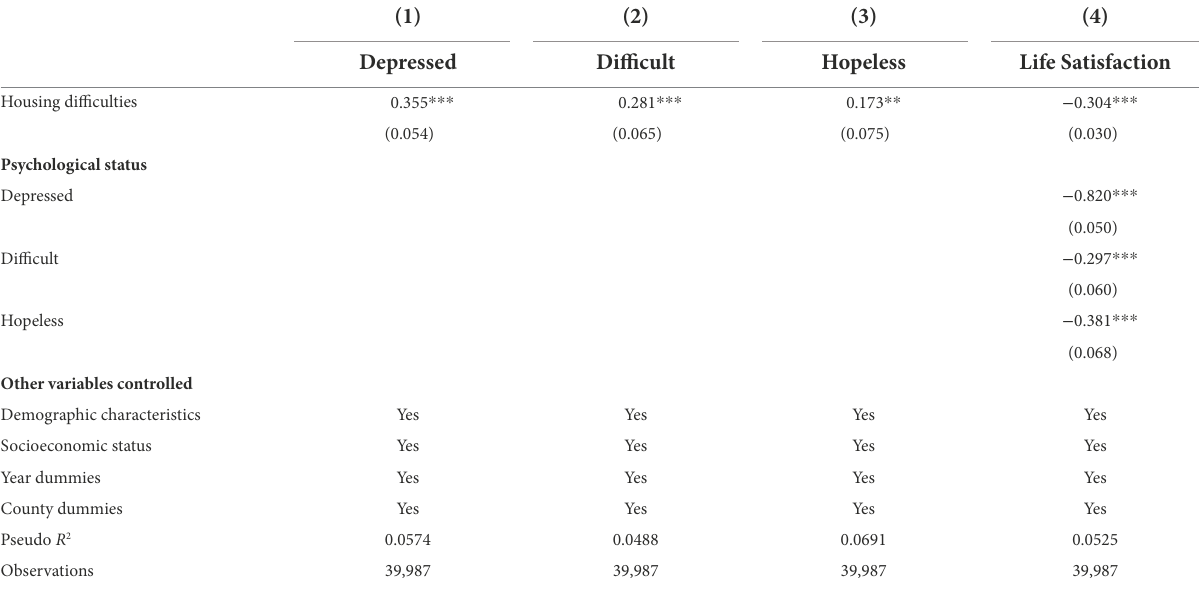
TABLE 4 Housing difficulties, psychological status and life